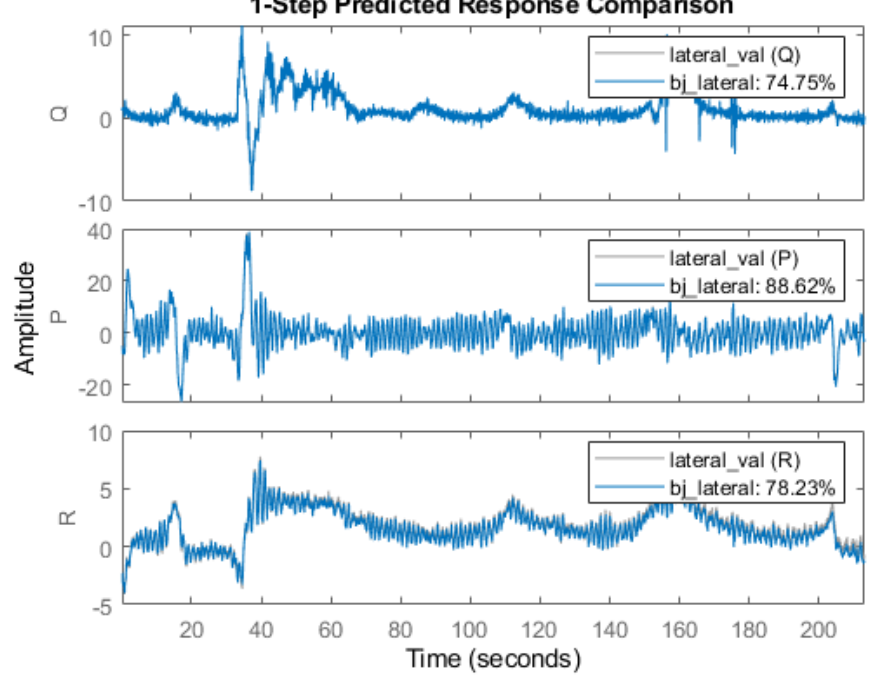
Figure 14. BJ Model